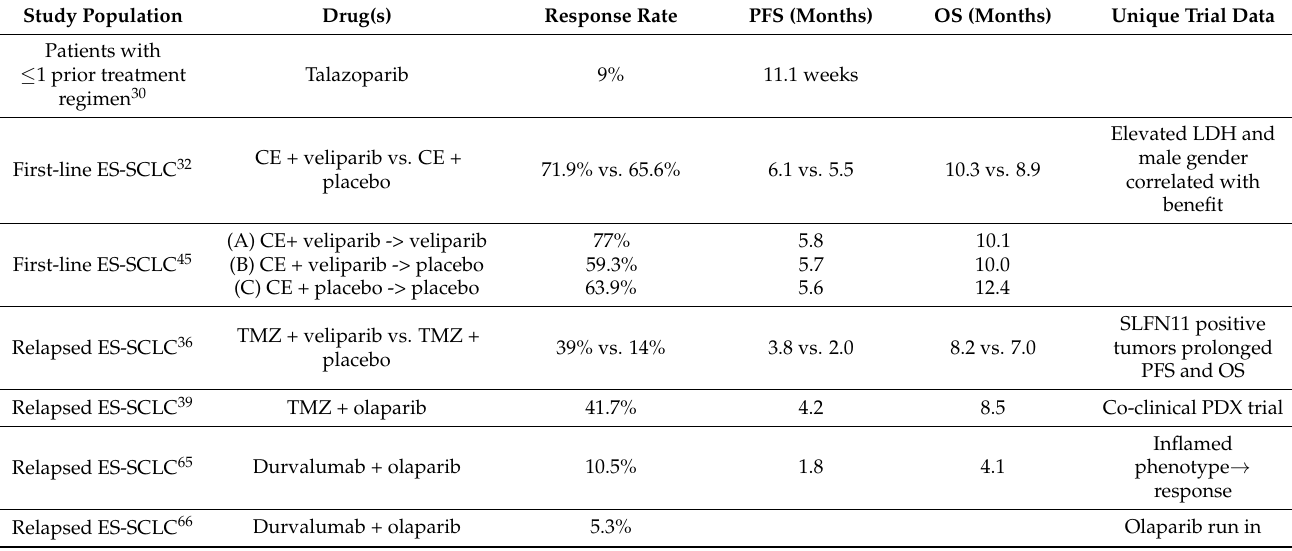
Table 1. Studies including PARP inhibitors in SCLC with outcomes